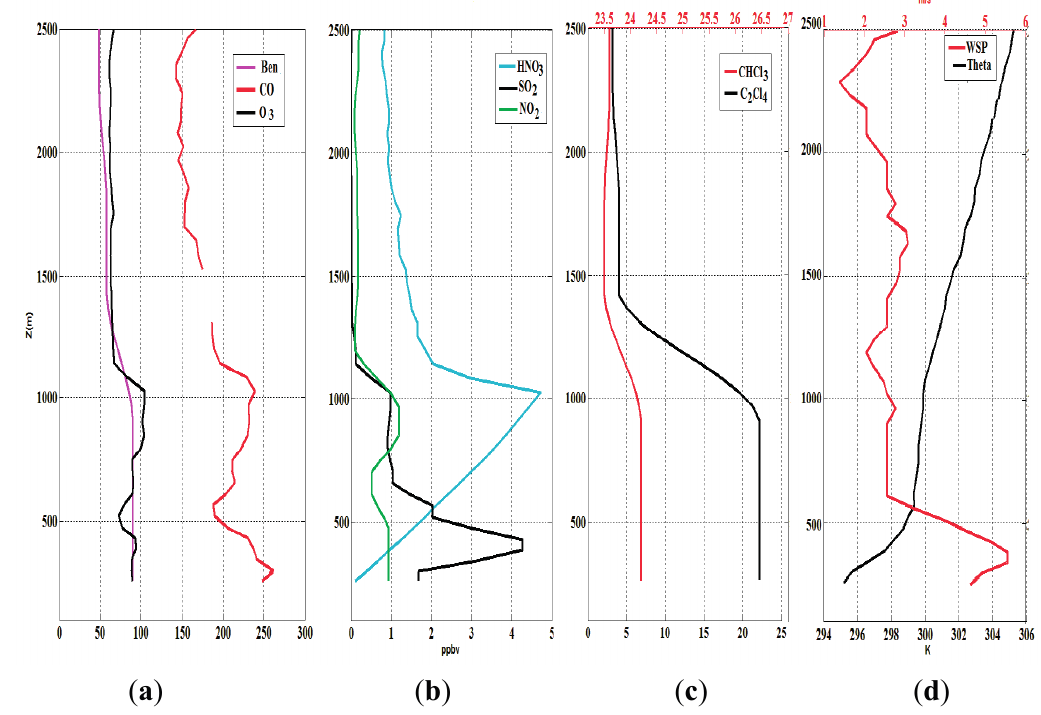
Figure 10. Cross-platform observations of the plume by the NASA DC-8, Shown are profiles of ( a ) primary trace gases Benzene; CO and O 3, as well as ( b ) HNO 3 , SO 2 and NO 2 ; Profiles of signature halocarbons CHCl 3 and C 2 Cl 4 are shown in ( c ) With physical parameters of wind speed (m/s) and potential temperature (K) in ( d